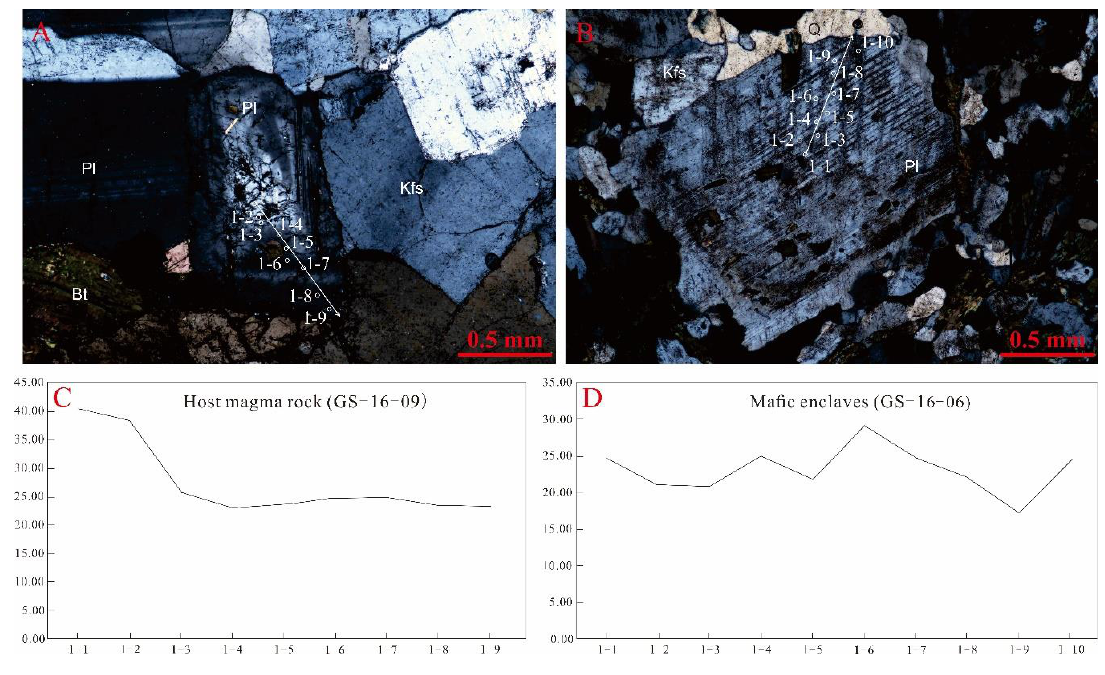
Figure 4. Locations and An values of the EPMA analyses points on the plagioclase crystals in the Qingshanbao host rock ( A , C ) and a mafic enclave ( B , D ).